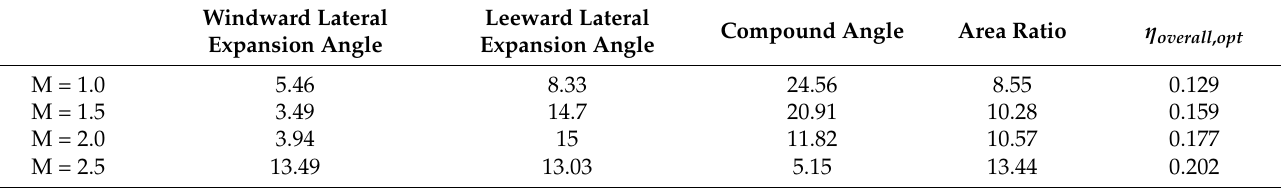
Table 3. Results of the optimized design variables at DR = 2.0.